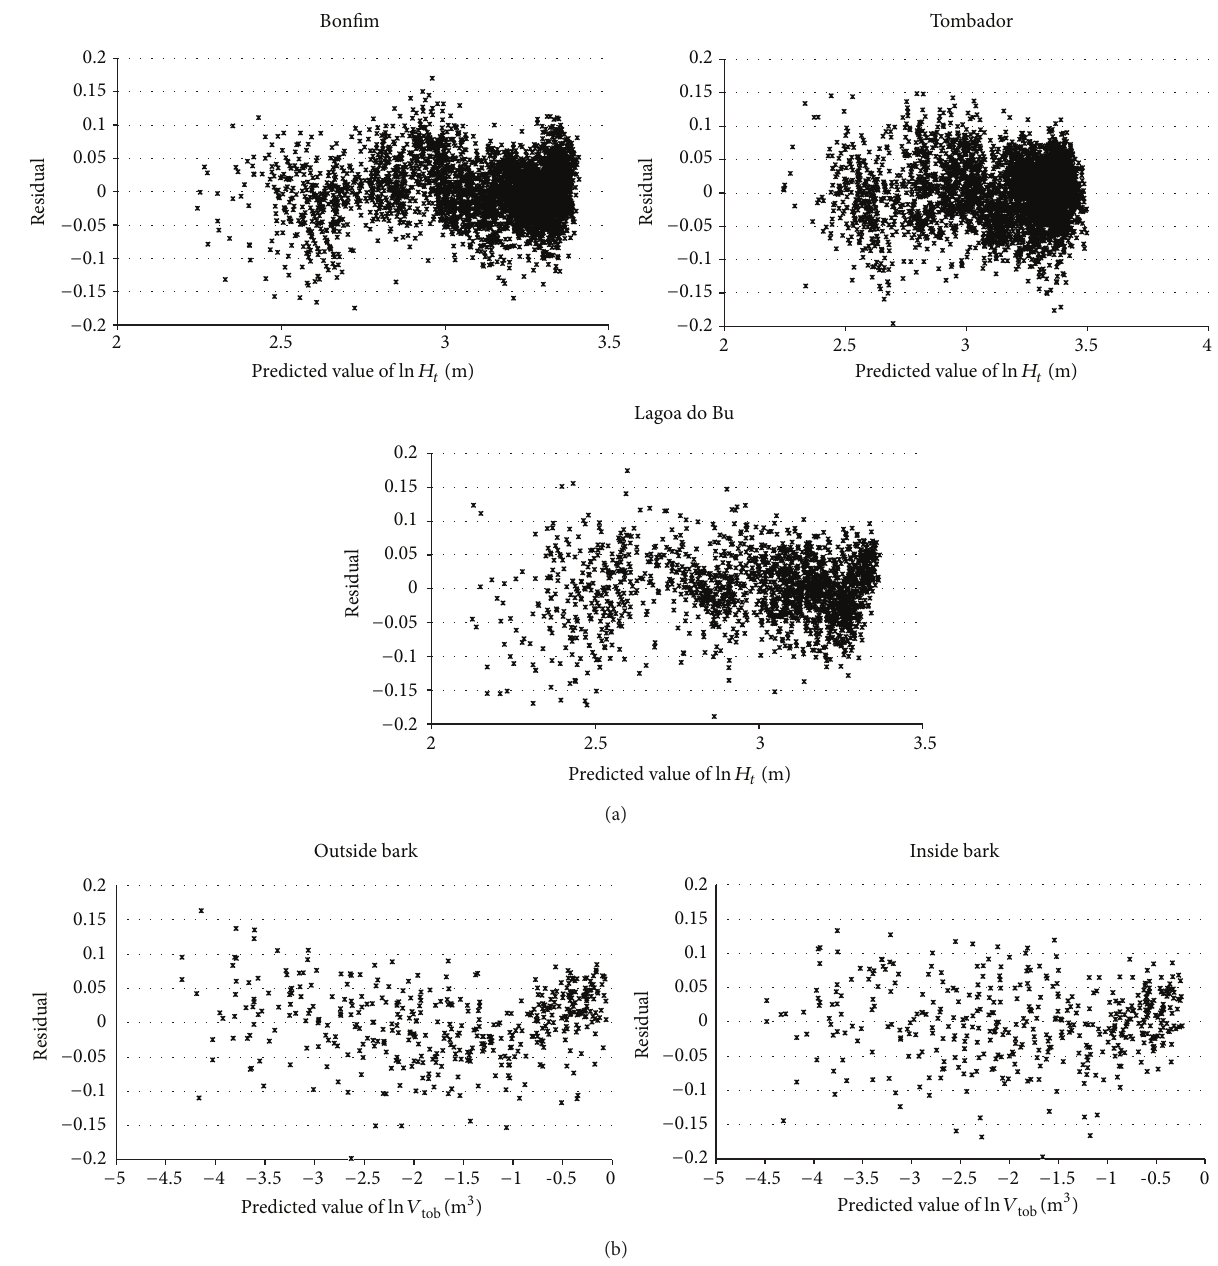
Figure 1: Residual versus predicted values for (a) the height prediction equations and (b) the outside and inside bark volume equations. The predicted and residual values are in natural logarithmic units of m for height (a) and m 3 for volume